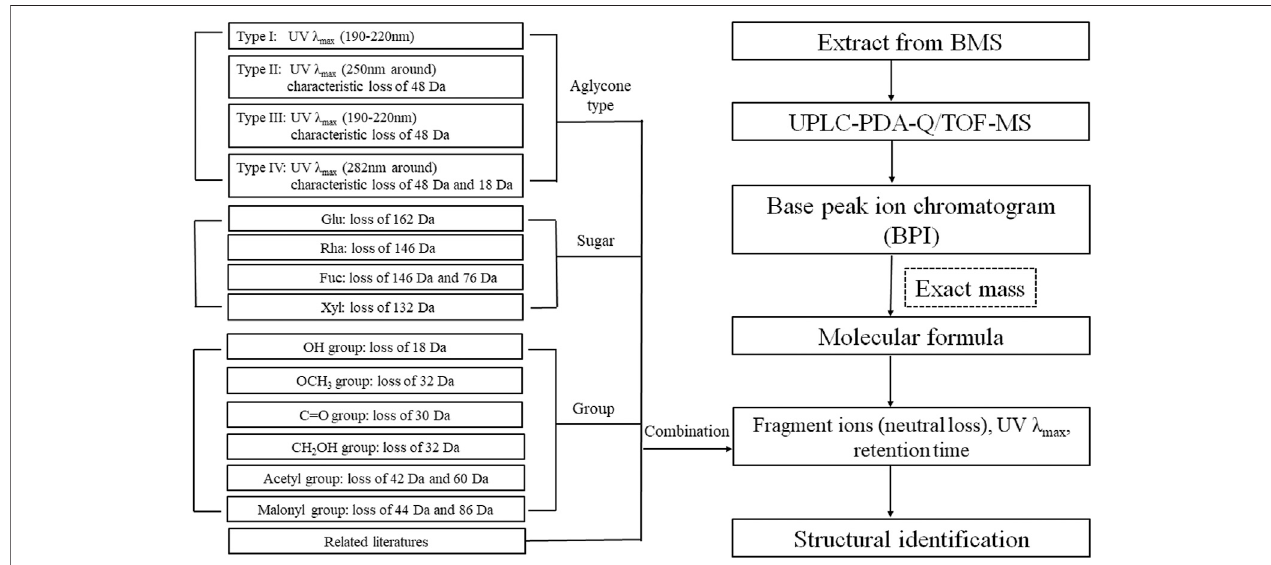
FIGURE 9 | Flowchart for the systematic identi fi cation of saikosaponins by UPLC-PDA-Q/TOF-MS combined with a screening method.